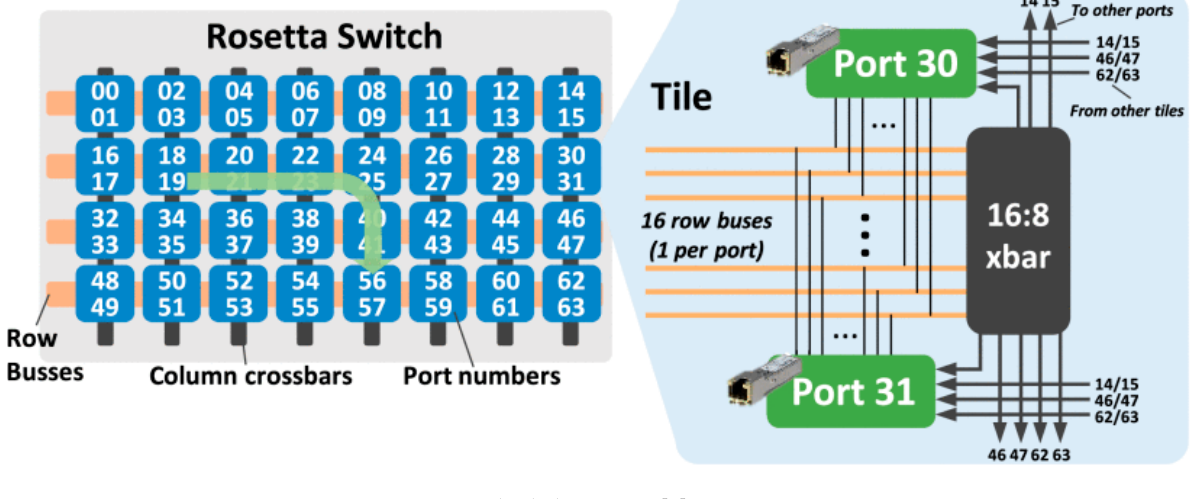
Figure 5. Rosetta switch tiled structure [6].